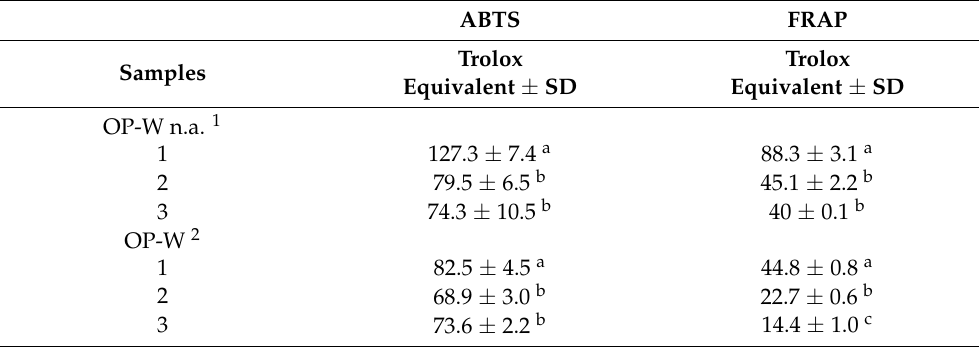
Table 5. The radical scavenging activity of aqueous OP extracts after in vitro digestion and dialysis. Values are reported as Trolox equivalent ( µ g TE/mg dry